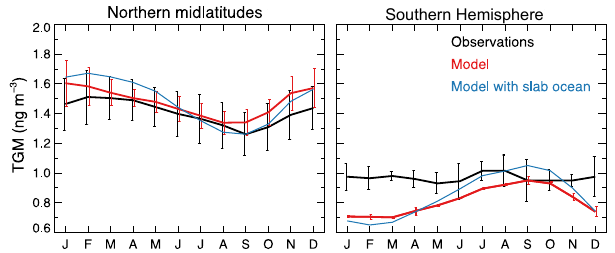
Figure 4. Mean seasonal variation and spatial standard deviation of total gaseous mercury (TGM) concentrations for northern midlati- tude sites (see Fig. 3) and Southern Hemisphere sites (Amsterdam Island and Cape Point). Observations are compared to our stan- dard GEOS-Chem simulation coupled to the MITgcm 3-D ocean model and to a sensitivity simulation coupled to the 2-D surface– slab ocean model in